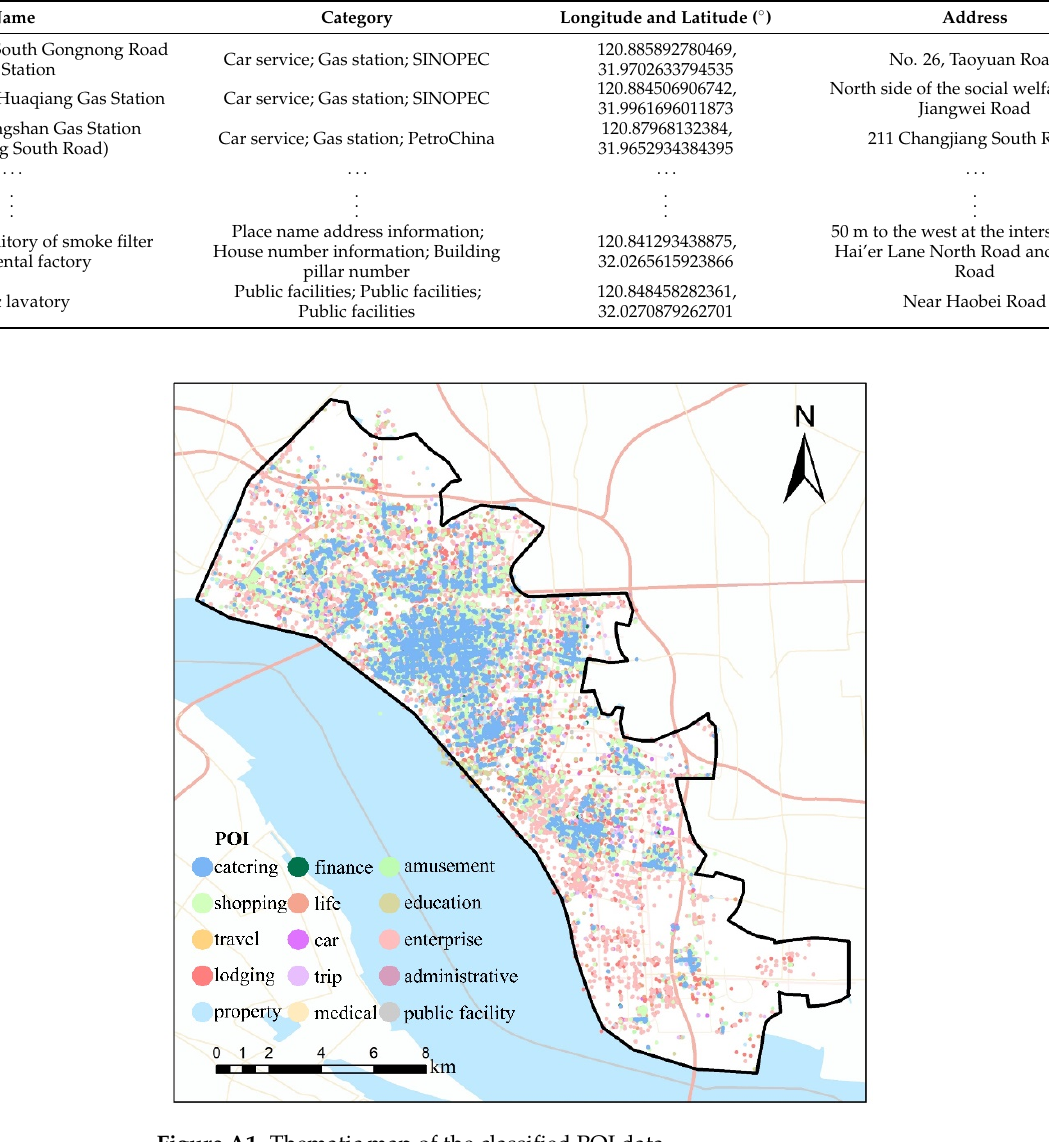
Figure A1. Thematic map of the classified POI data.